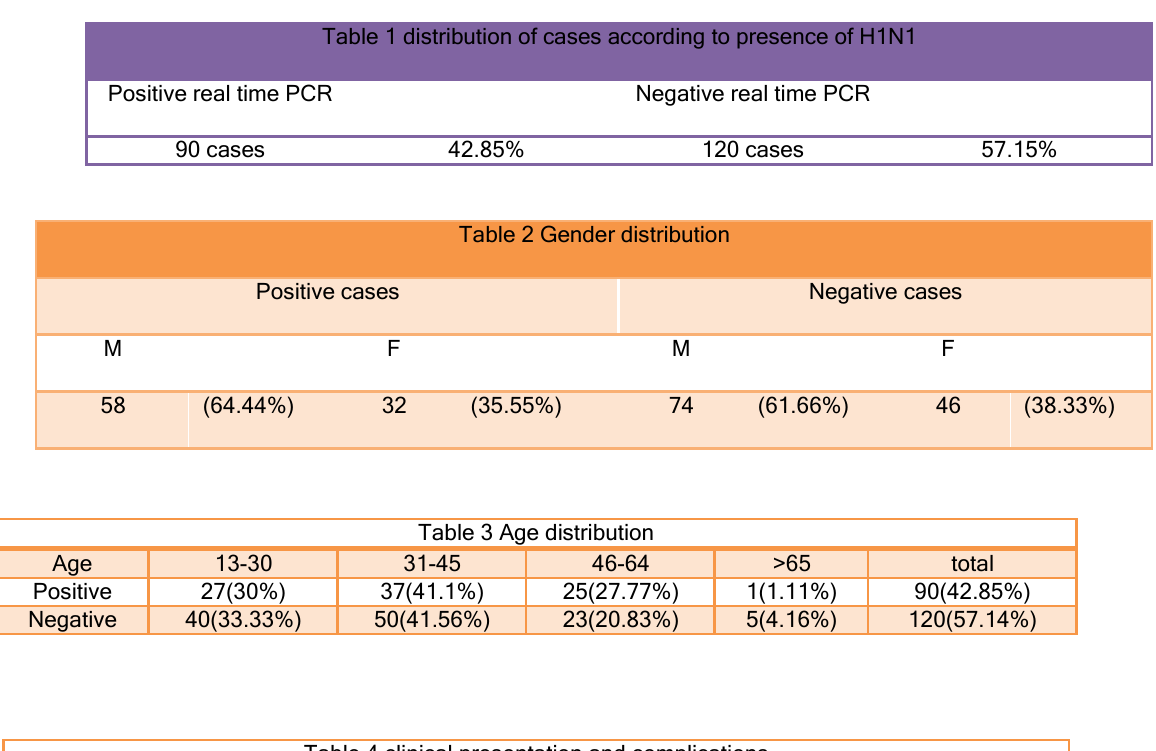
Table 2 Gender distribution